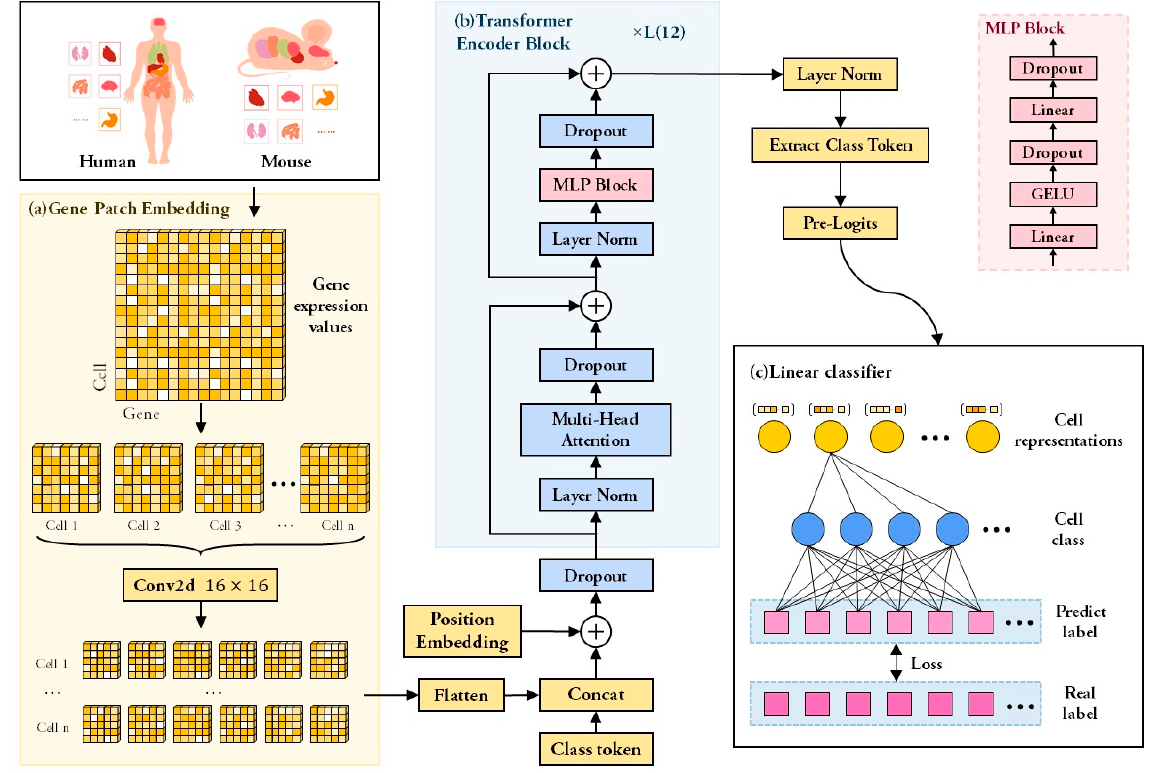
Figure 1. The architecture of the scTranSort. ( a ) The gene patch-embedding layer. Receive scRNA-seq data, transform it into a two-dimensional matrix of gene expression, and generate gene-embedding patches; ( b ) The transformer encoder block. It consists of a multi-head self-attention mechanism and a fully connected feedforward network to obtain a high-dimensional vector representation of the input sequence; ( c ) The linear classifier layer. The input represented by the high-dimensional vector is mapped to a set of cate-gory probabilities to obtain the final classification result. The linear classifier layer consists of a three-layer MLP, which is composed of multiple linear layers and nonlinear activations [43]. The high-level features output by the transformer encoder block are used as input to the MLP and, by assigning a confidence level to each cell type, the final output of the predicted cell type results. The gaussian error linear units (GELU) are used as the activation function. Since the cumulative distribution function of GELU is usually calculated using the error function, GELU is defined as